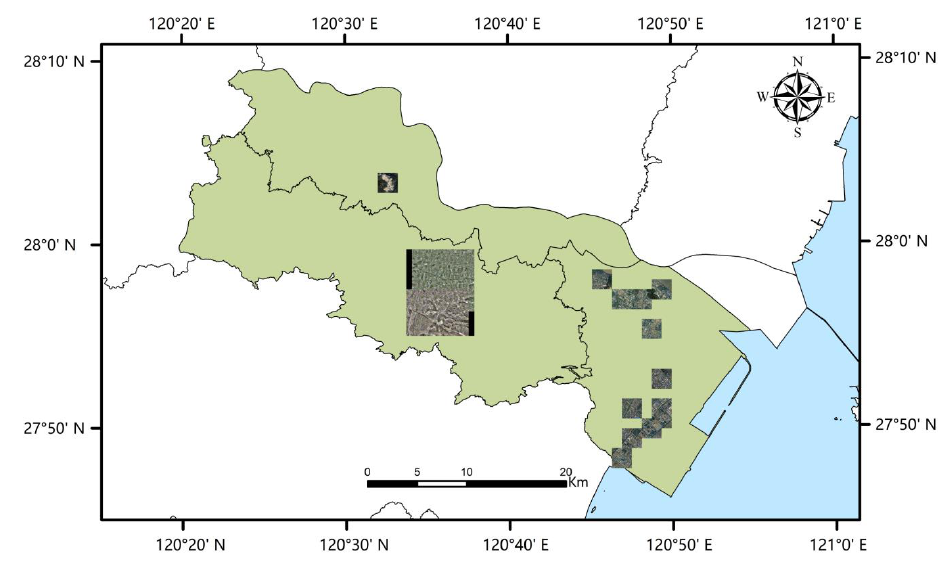
Figure 1. The spatial location of the study area of Wenzhou City,